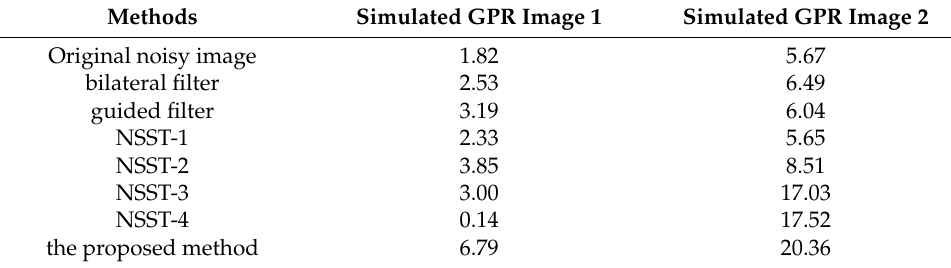
Table 3. TNR results of different denoising